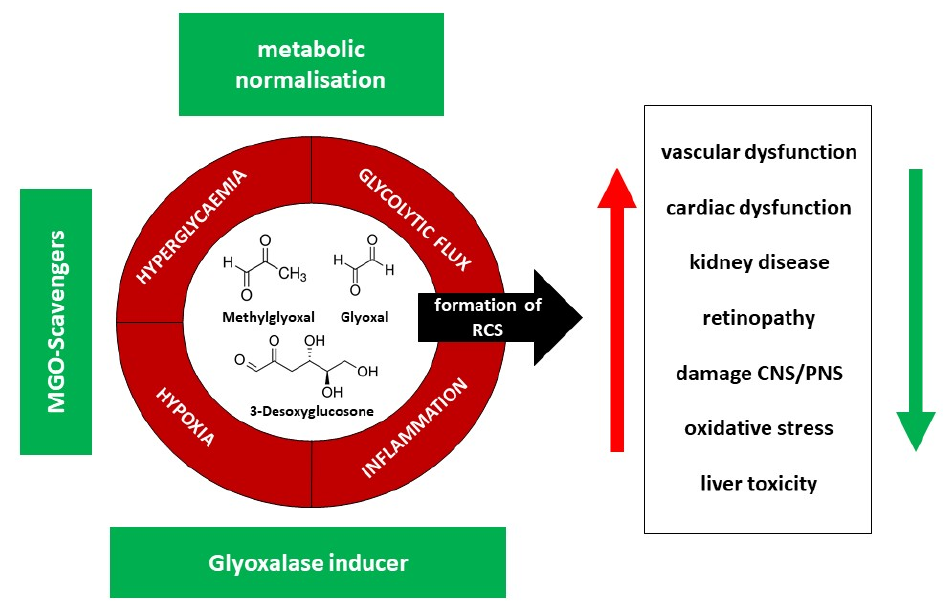
Figure 4. Effector pathways (red) and possible solutions (therapeutic options) (green) to overcome negative effects in reactive dicarbonyl and AGE generation, RCS = reactive carbonyl species, CNS = central nervous system, PNS = peripheral nervous system.